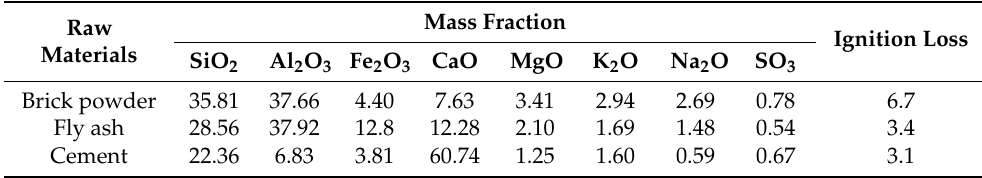
Table 1. Chemical compositions of raw materials (%).